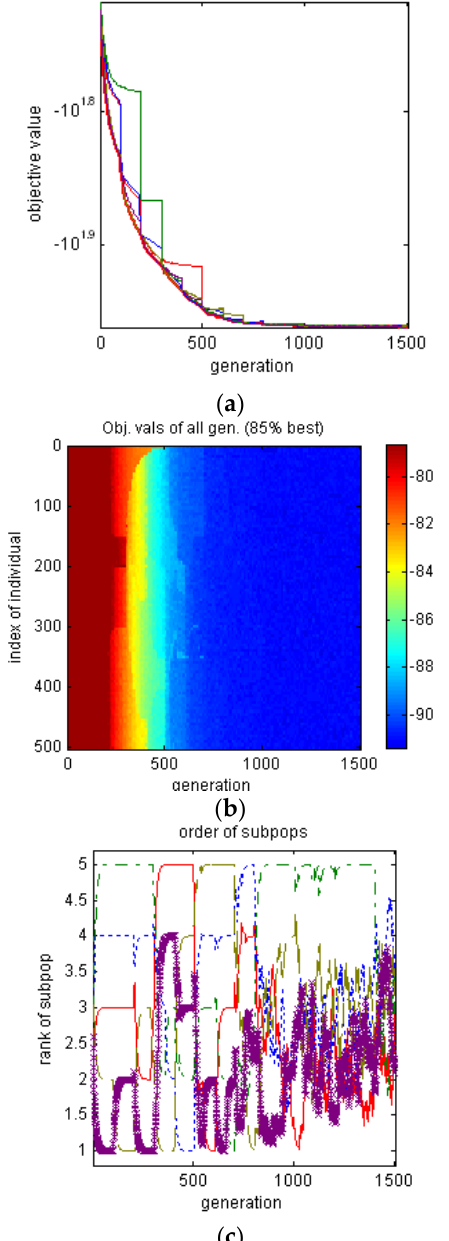
Figure 10. The convergence of the IGA evolution. ( a ) The changes of the best affinity in selected five populations among the 1500 generations are shown by the different colors (the thick red line is the best affinity for all populations). Evidently, affinity has gradually converged after 1000th generations. ( b ) The best affinity changes of antibodies are displayed in 3D heat map. ( c ) The affinity changes among the populations before 500th generations are fast, and the rate becomes moderate after 500. Slowly converged population may also produce the best affinity antibody due to the IGA migration mechanism with antibody exchange. After 1000 generations, the affinity between populations become indifferent.